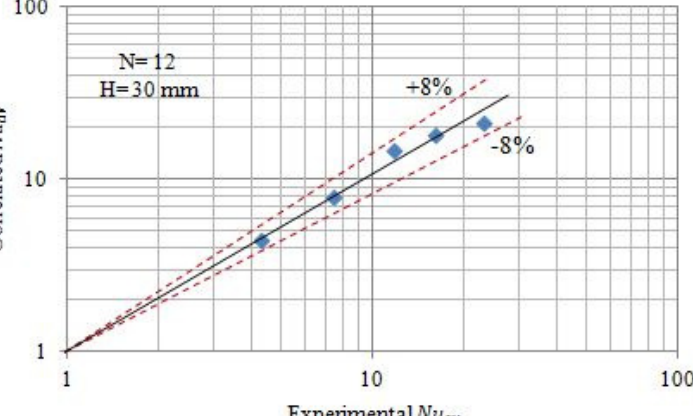
Fig. 10. Comparison of correlated average Nusselt numbers with those of the present experimental work for continuous longitudinal fins.